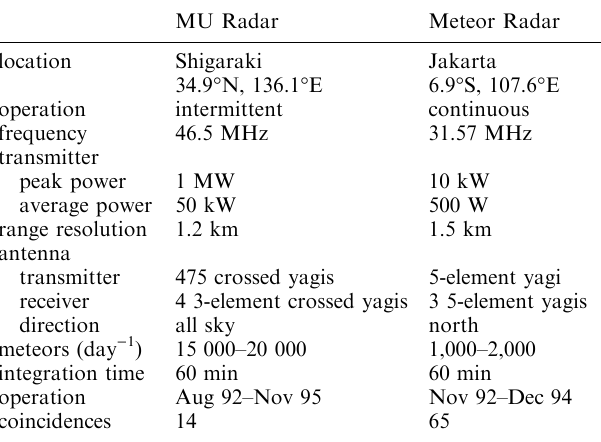
Table 1. Specifications for the meteor radars used in this study MU